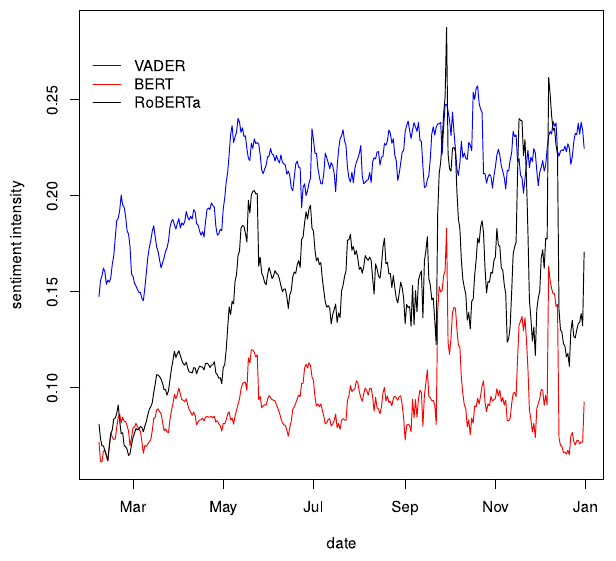
Figure 8. Year–Long time series of daily averaged compound sentiment polarity variance of COVID-19- related tweets in Mexico . Each line represents a time series based on the same dataset collected [6] and restricted to Mexico, from 2 February to 31 December 2020. Data were smoothed via a 7-day rolling